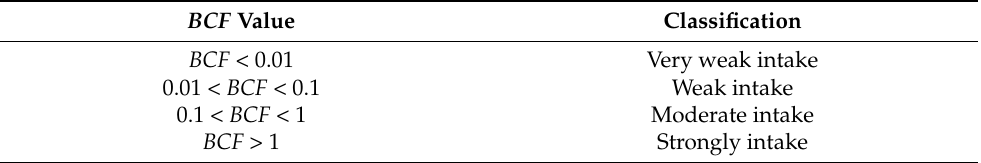
Table 1. Classification criteria for the bioconcentration factor ( BCF